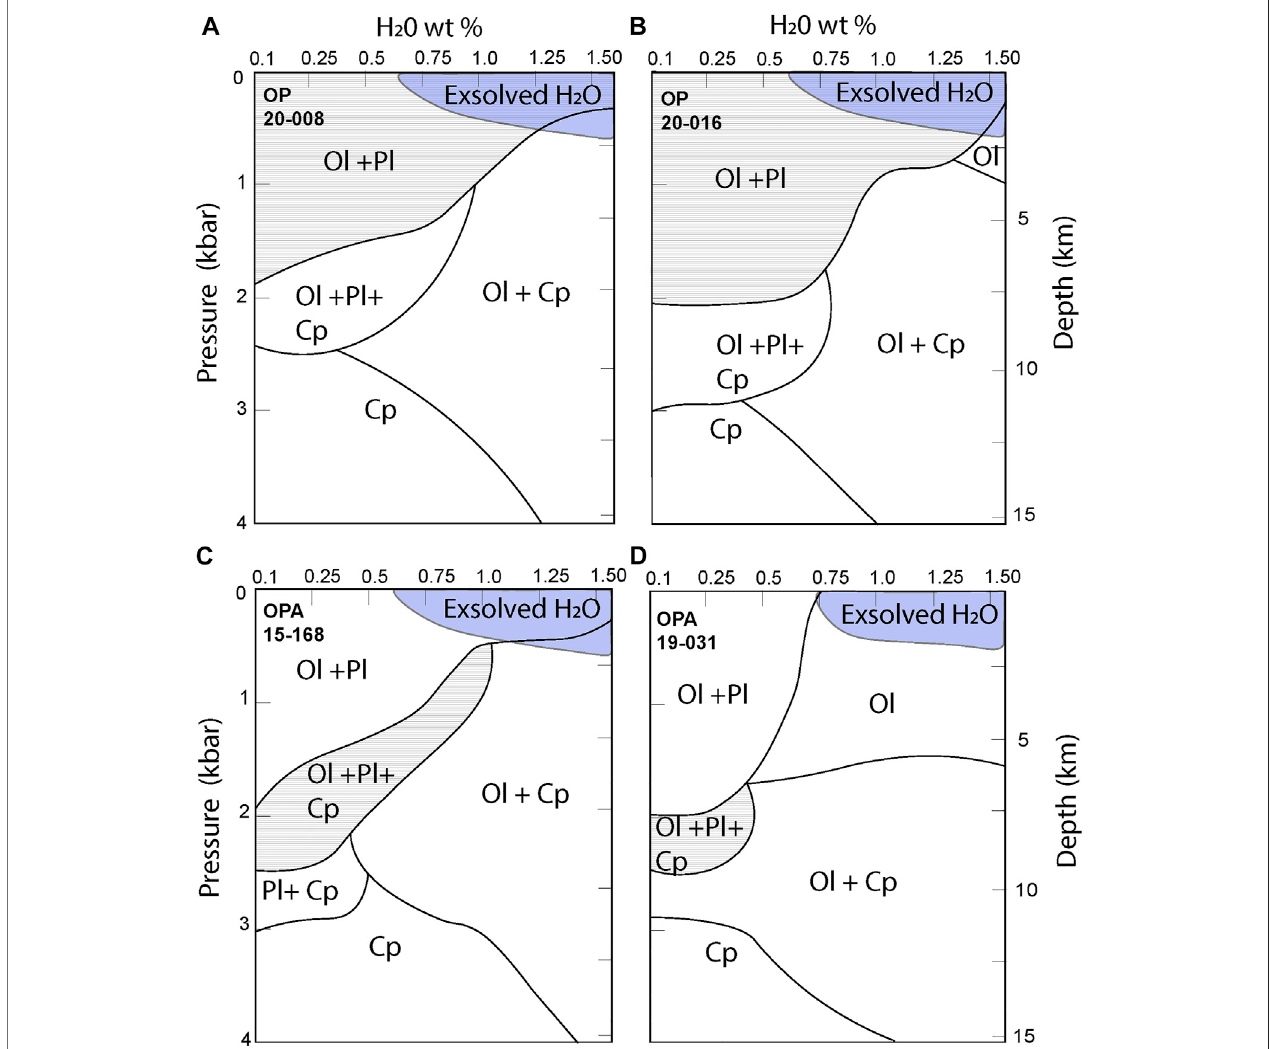
FIGURE 5 | Phase portraits for CM volcanic samples, displaying mineral stability fi elds as a function of pressure and H 2 O (wt%) resulting from crystallization simulationsusingRhyolite-MELTS(Gualdaand Ghiorso, 2015).Individualsimulationswererunatisobaricconditionsranging from 4to0 kbar. Ateachpressureinterval, simulationsweremodeledwithvaryingH 2 Owt%,rangingfrom0.1to1.5% (A,B) PhaseportraitsfortwoOPsamples(20-008and20-016); (C,D) Phaseportraitsfortwo OPAsamples(15-168and19-031).Dashed fi eldsshowstablemineral fi eldsforOPandOPAsamplesrespectively.Conditionsatwhichwaterbecameanexsolved phase are indicated in each plot (blue shaded fi